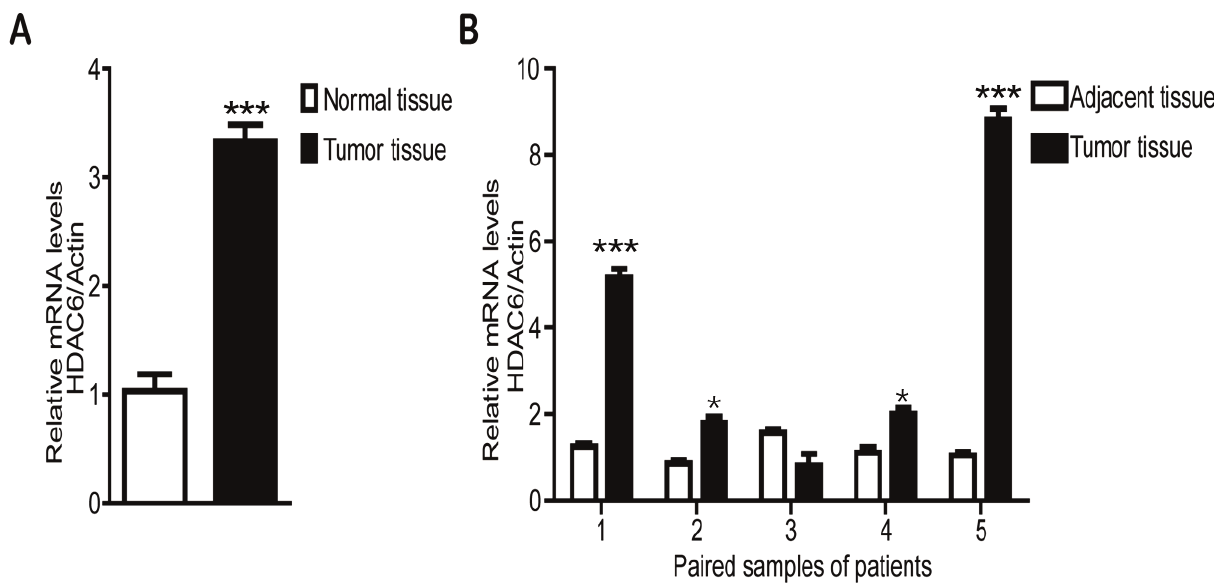
Figure 1: (a) HDAC6 mRNA in tissues from patients with GBM (b) HDAC6 mRNA in tumor tissues compared with adjacent tissue of tumor from single patients.The data shown in the figure was derived from 3 independent experiments. *P < 0.05, ***P < 0.001 versus normal tissue in panel A and versus adjacent tissue in panel